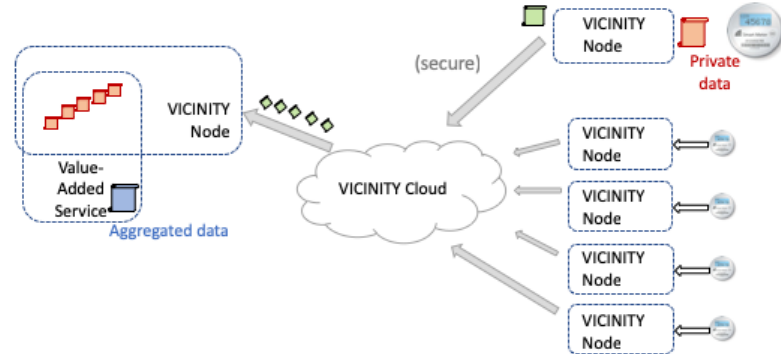
Figure 8. Use case integrated into the VICINITY network. Private data are available to value-added service in clear text.